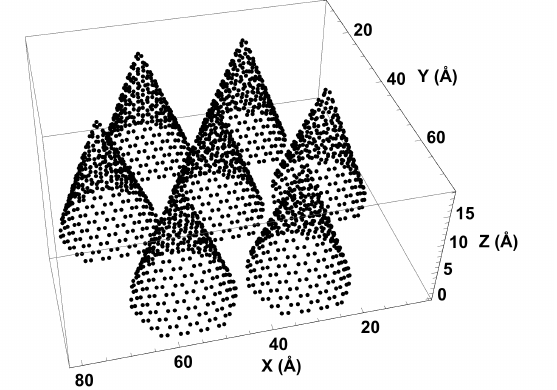
Figure 1. Simulation cell with seven